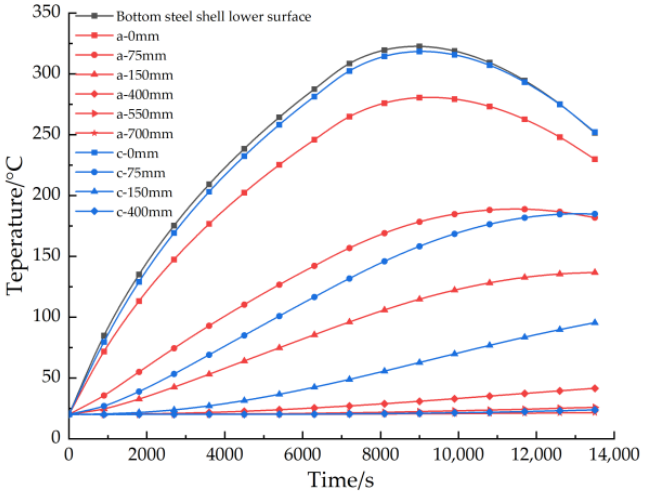
Figure 23. Forward contour plot of the member under the protection of fireproof coating at 13,500 s.